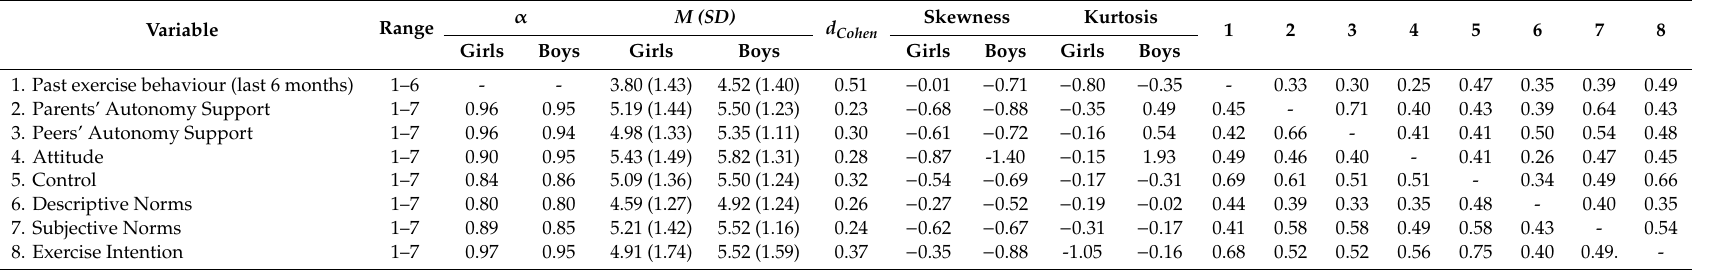
Table 1. Descriptive Statistics and Bivariate Correlations among Variables.